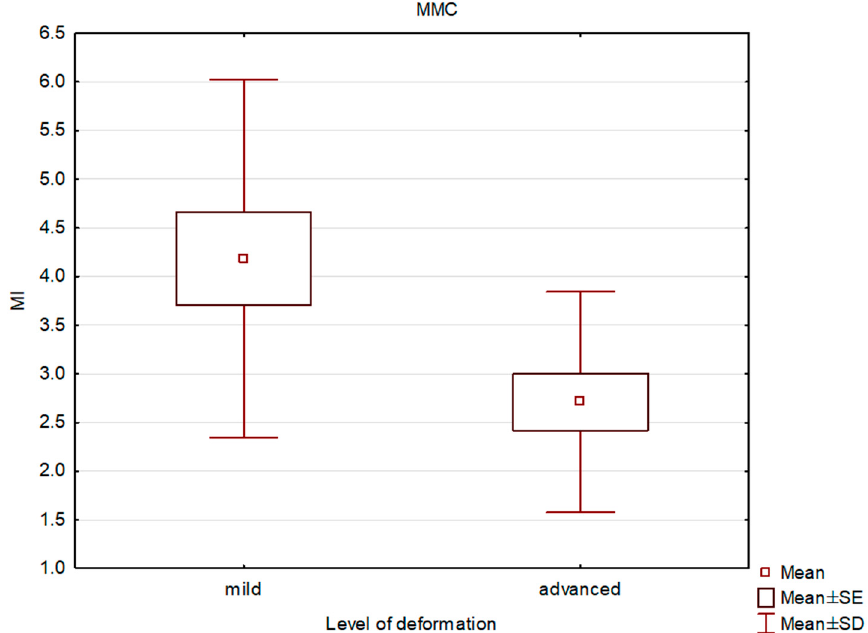
Figure 8. Box and whisker plot of the mineralization index (MI) in patients with mild and advanced deformity in the medial part of the medial condyle (MMC).